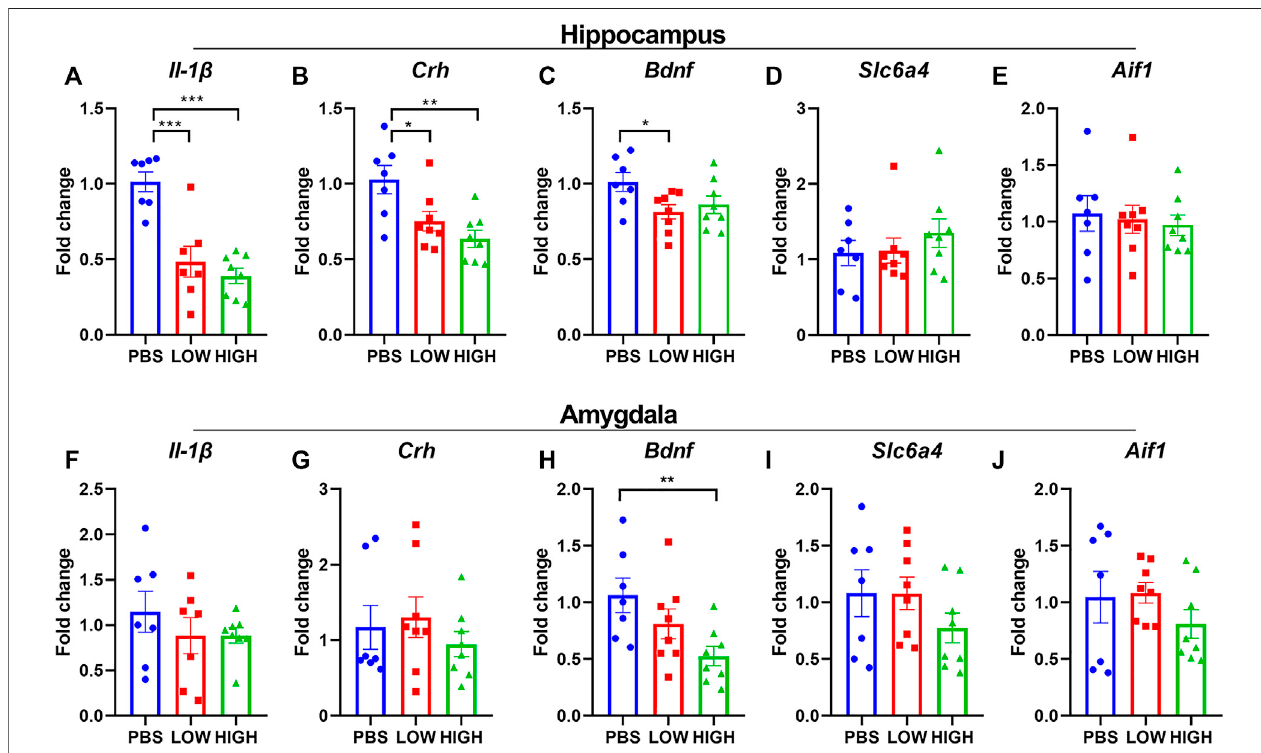
FIGURE 5 | Effects of HCQ on the mRNA expression of genes in the hippocampus and amygdala of mice in the lasting group (A – E) mRNA expression of (A) Il-1 β (B) Crh (C) Bdnf (D) Slc6a4, and (E) Aif1 in the hippocampus (F – J) mRNA expression of (F) Il-1 β (G) Crh (H) Bdnf (I) Slc6a4, and (J) Aif1 ( n (cid:1) 7 − 8 for each subgroup; one-way ANOVA; * p < 0.05, ** p < 0.01, *** p < 0.005).